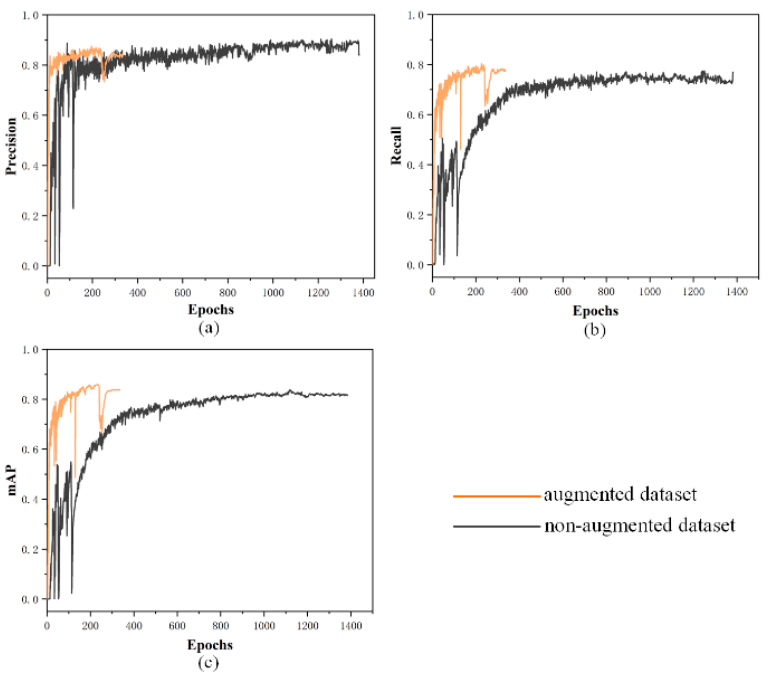
Figure 12. The variation curves of different metrics when the model was trained using an augmented dataset and a non-augmented dataset: ( a ) Precision curve of the models; ( b ) recall curve of the models; ( c ) mAP curve of the models. Table 4. The performance of the detection models.